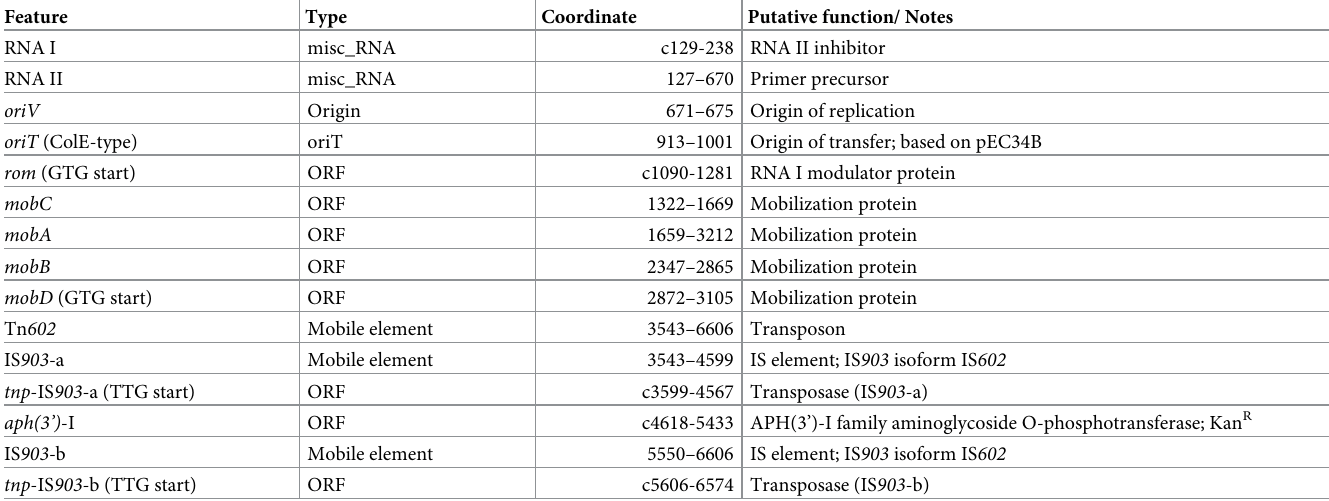
Table 2. Plasmid pSNC3-Kan